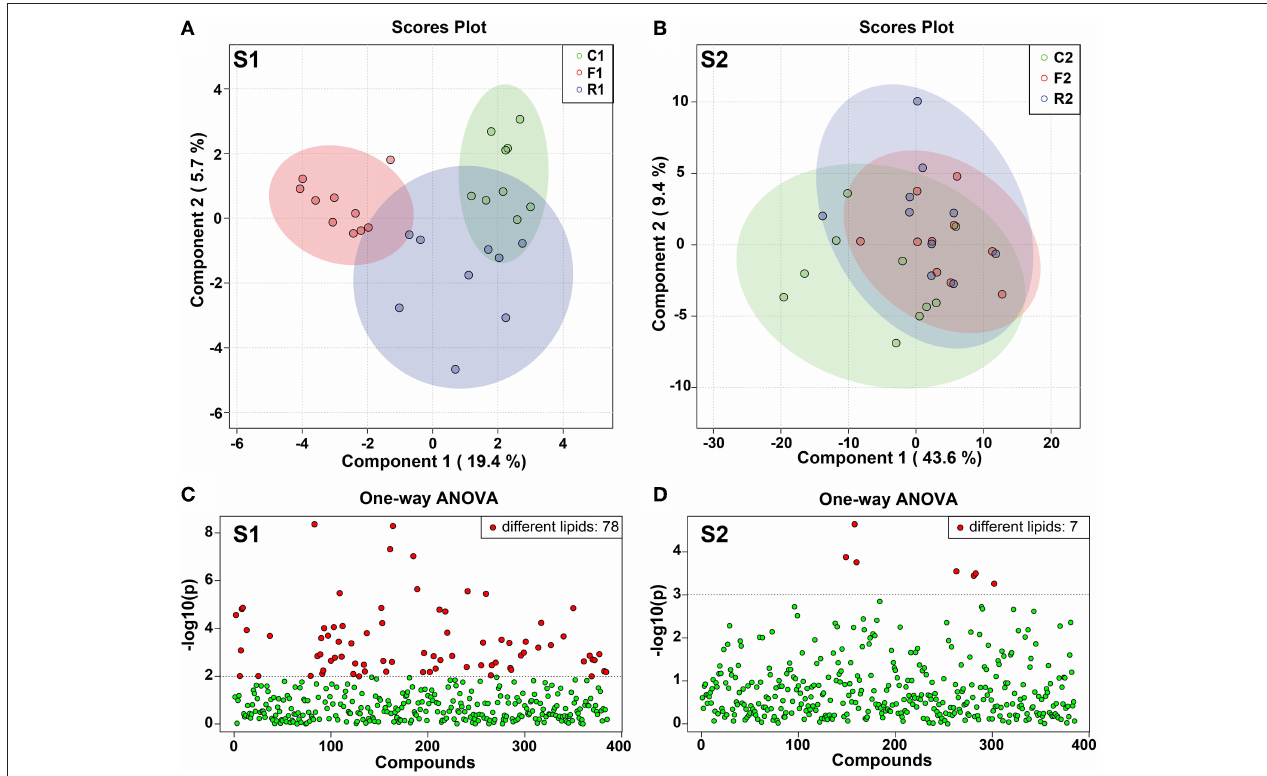
FIGURE 5 | PLS-DA score plot and distribution of the differential lipids. (A) PLS-DA score plot at stage 1 (S1). (B) PLS-DA score plot at stage 2 (S1). (C) Distribution of differential lipids from one-way ANOVA analysis at stage 1 (S1), showing 78 different lipids. (D) Distribution of differential lipids using one-way ANOVA analysis at stage 2 (S2), showing 7 different lipids. n = 9–10. (R1 have 9 rats, C1, F1, C2, R2, and F2 have 10 rats). “ n ” means the number of samples/rats per group.